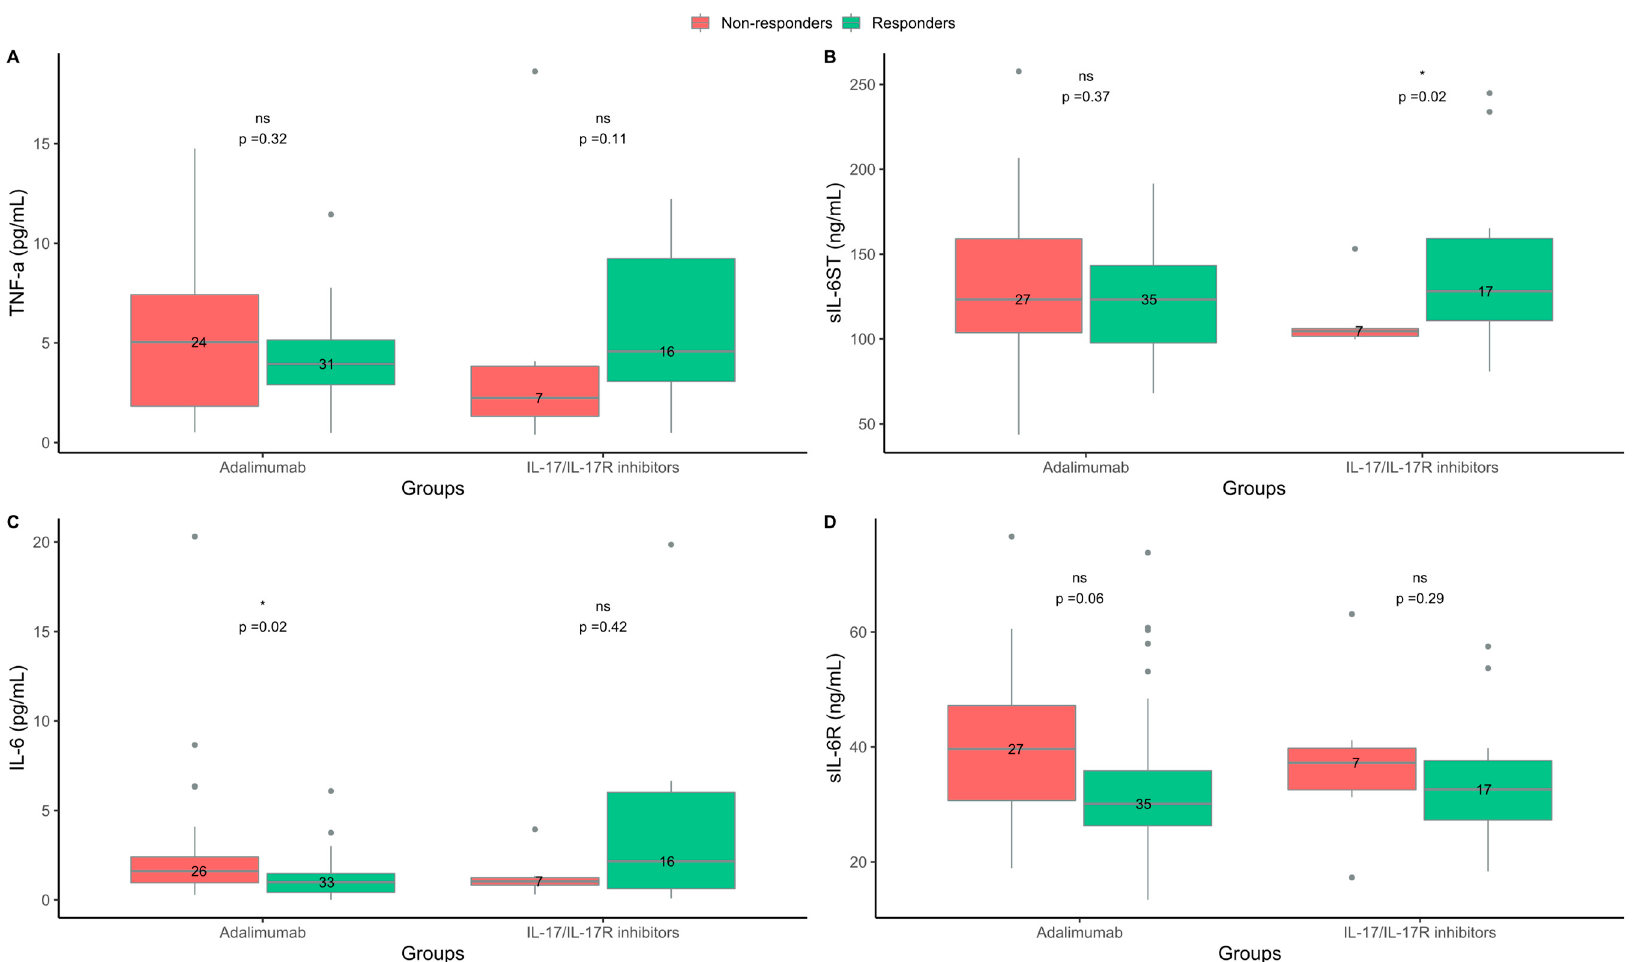
Figure 3. Blood cytokine levels at baseline in responders and non-responders to treatment with adalimumab or interleukin (IL)-17/IL-17R inhibitors. ( A ) Tumor necrosis factor (TNF)- α . ( B ) Soluble interleukin-6 signal transducer (sIL-6ST). ( C ) Interleukin-6 (IL-6). ( D ) Soluble interleukin-6 receptor (sIL-6R). Responders = psoriasis area and severity index (PASI) ≤ 2 three months after treatment start. Non-responders = PASI > 2 three months after treatment start. * p < 0.05. ns = non-significant.